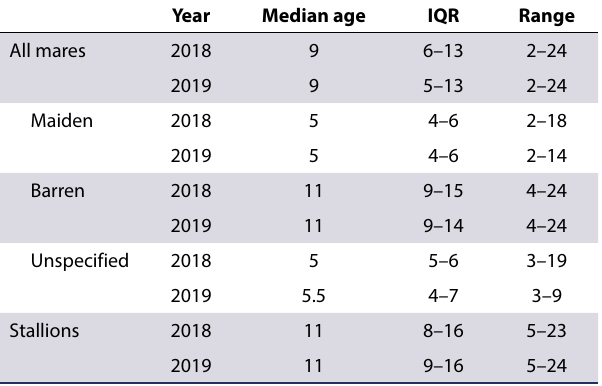
Table I: Summary statistics of the ages (years) of Thoroughbred mares and stallions tested as part of the 2018 and 2019 South African stud health scheme